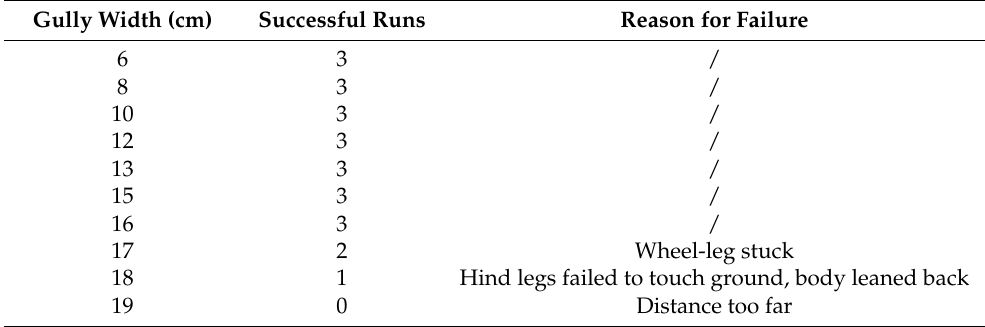
Figure 13. Experiment of robot crossing gullies. Table 4. Experimental results of robot jumping task. Gully Width (cm) Table 4. Experimental results of robot jumping task.